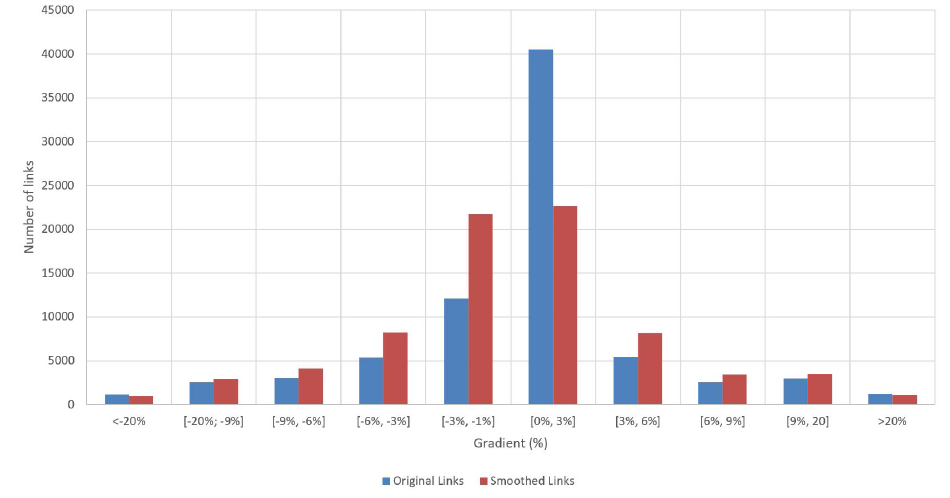
Figure 10. Network links gradient distribution: original and smoothed estimation of